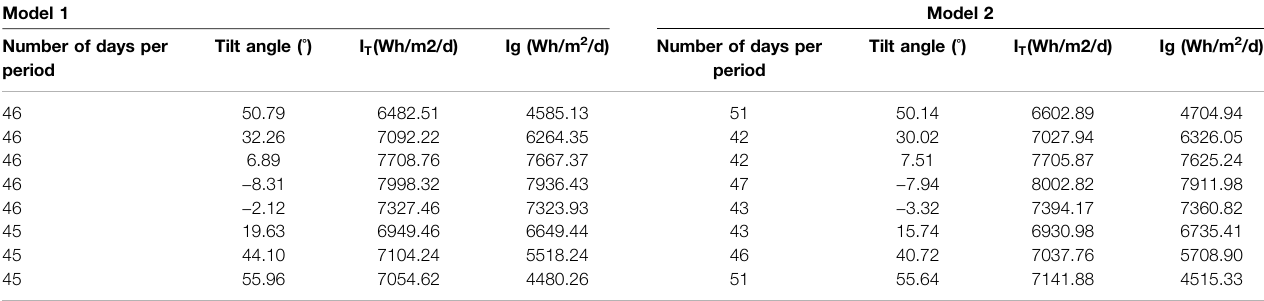
TABLE 3 | Optimal results found for Yanbu city for NP (cid:1)